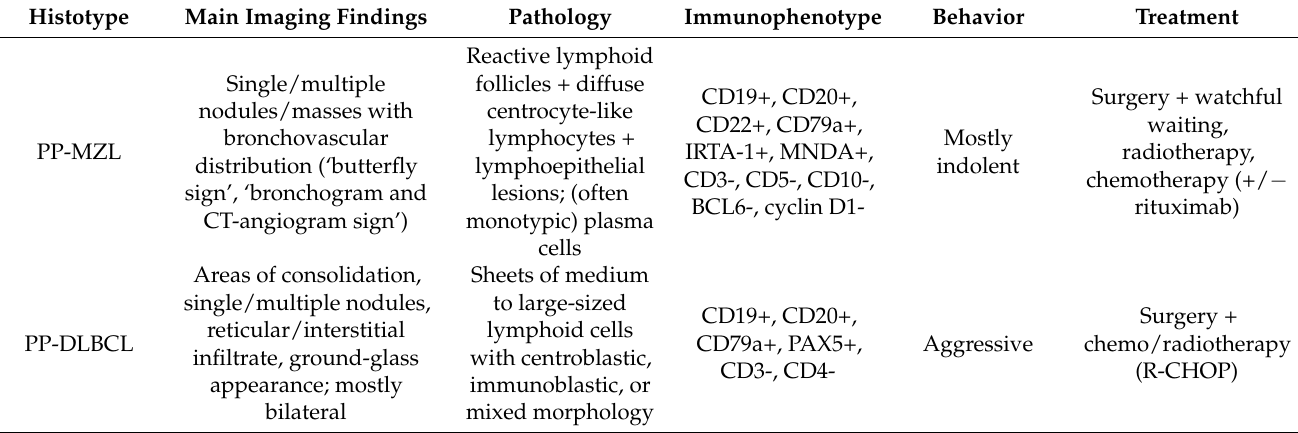
Table 1. Summary of the main features of primary pulmonary B-cell lymphoproliferative